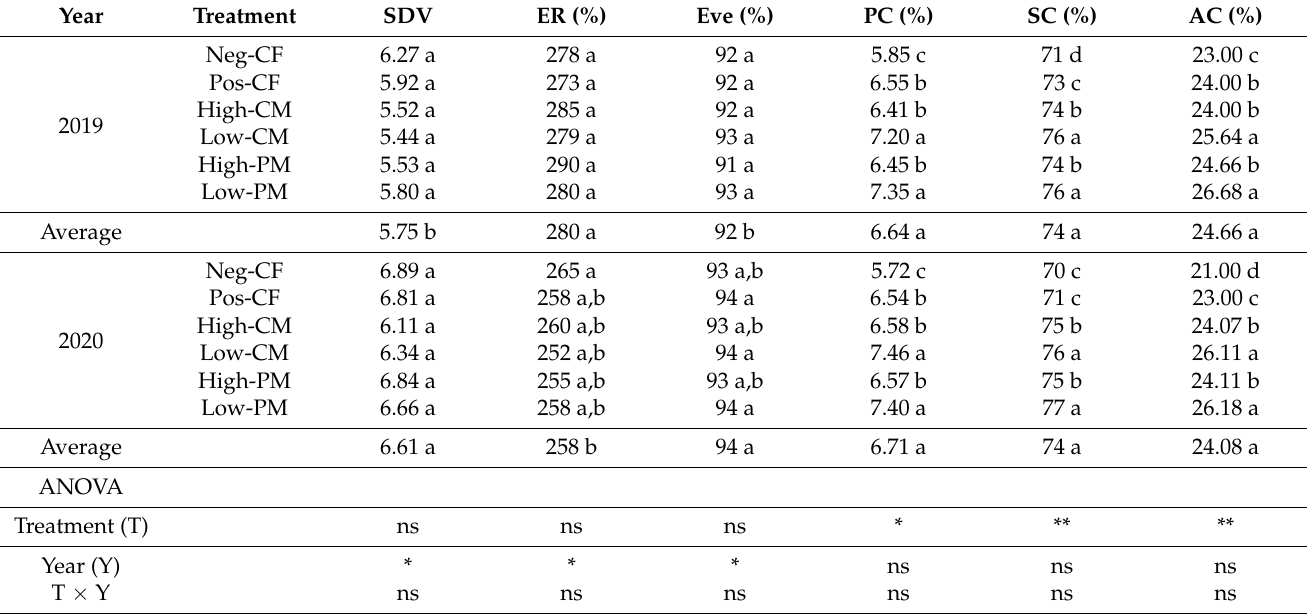
Table 3. Changes in grain nutritive and cooking traits under combined organic and inorganic